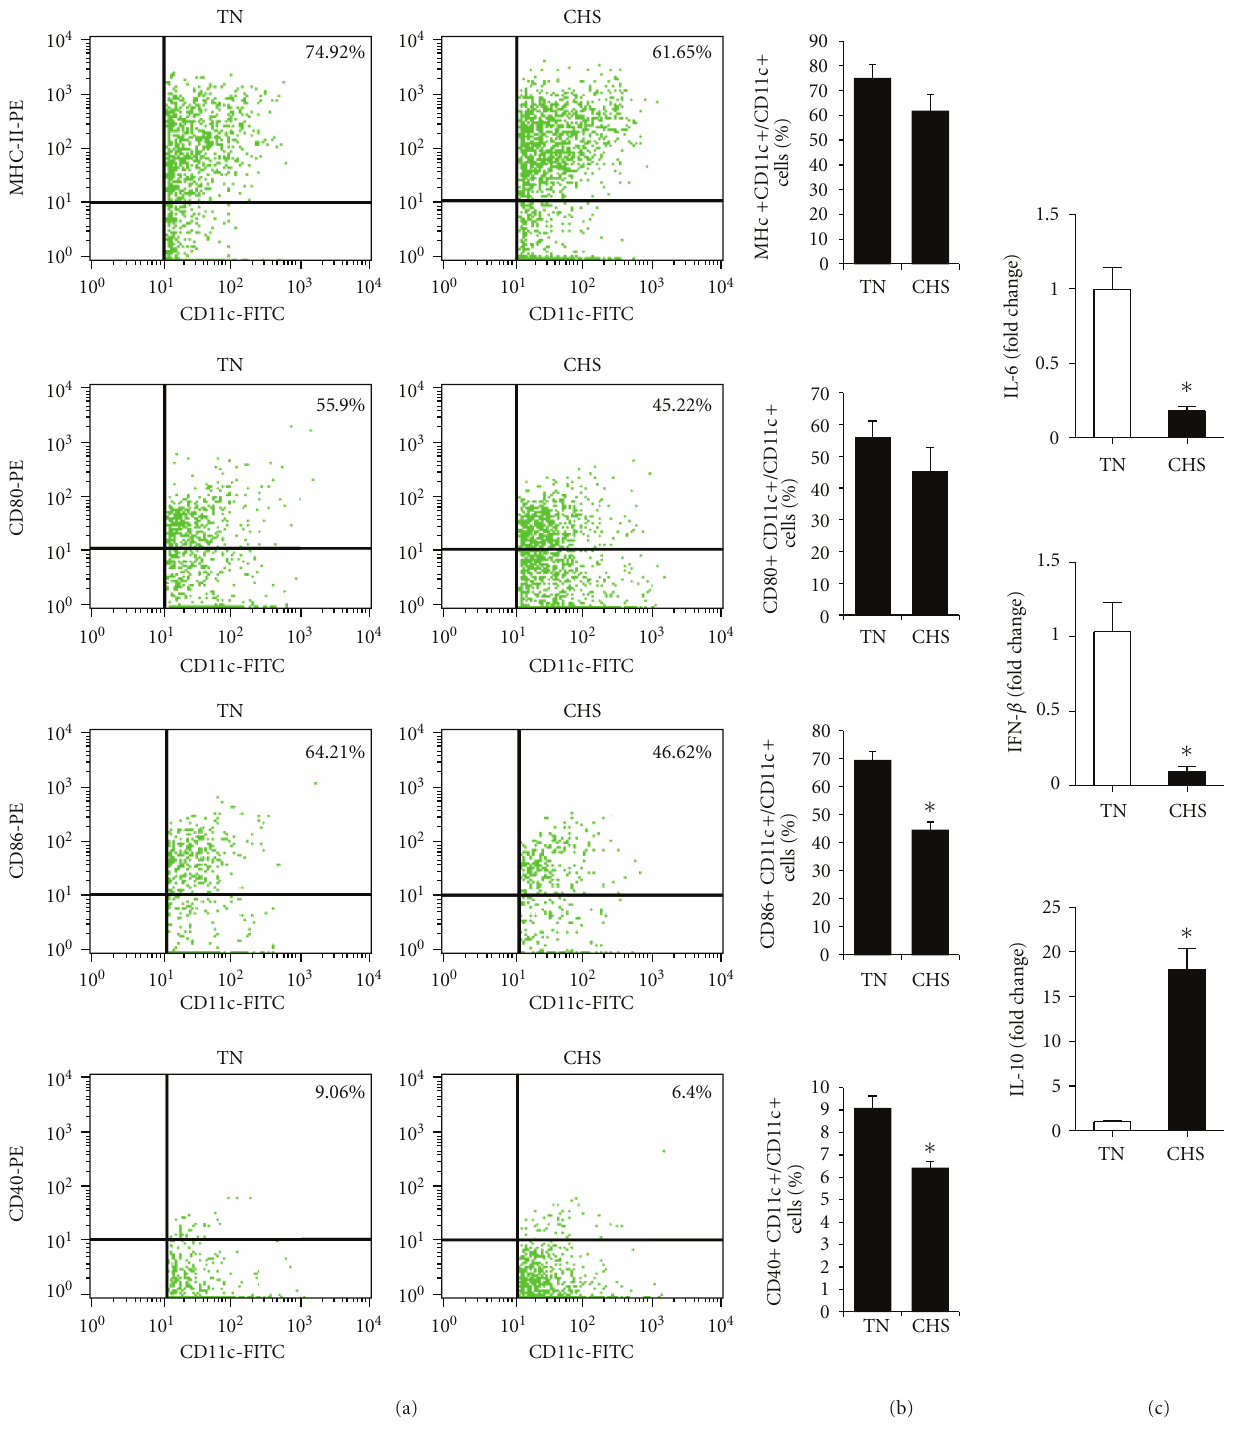
Figure 2: Analysis of maturation of DCs and innate immunity associated cytokine expression in mice. (a) Total splenocytes were isolated from the spleen of mice exposed to 38 ± 1 ◦ C or 24 ± 1 ◦ C over 21 days. Double staining for MHC-II+ CD11c+, CD80+ CD11c+, CD86+ CD11c+, and CD40+ CD11c+ cells was performed. The proportion of double-positive cells in the dot-plot are shown in the upper right corner of the quadrant, with the gate set for CD11c+ cells or events. Data shown are representative of three independent experiments. (b) Summaries of the proportion of MHC-II+ among total CD11c+ cells, CD80+ among CD11c+ cells, CD86+ among CD11c+ cells, and CD40+ among CD11c+ cells. (c) IL-6, IFN- β , and IL-10 mRNA levels from the spleens of mice exposed to 38 ± 1 ◦ C or 24 ± 1 ◦ C for 21 days were determined by qPCR. These results are the mean ± SD values obtained from three distinct animals and are representative of three independent experiments. ∗ indicates P < . 05 when compared with the TN